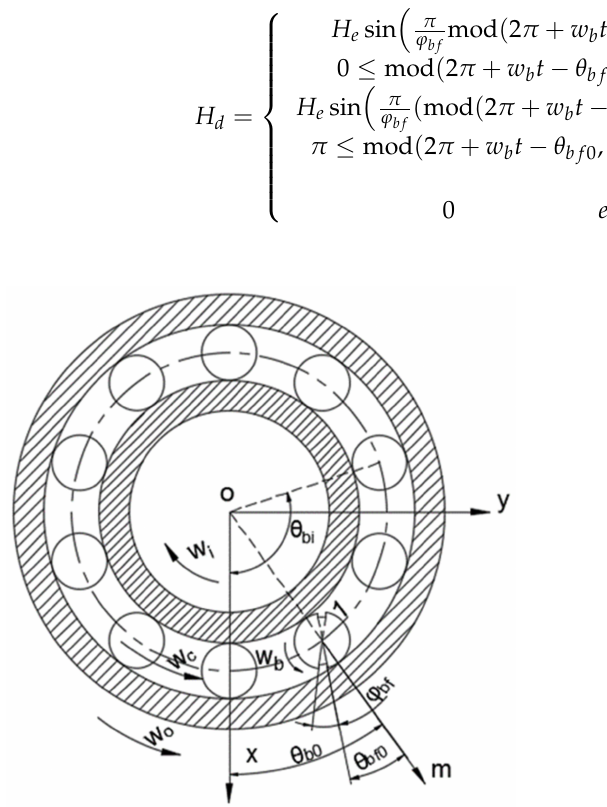
Figure 7. Roller and defect angular position of roller